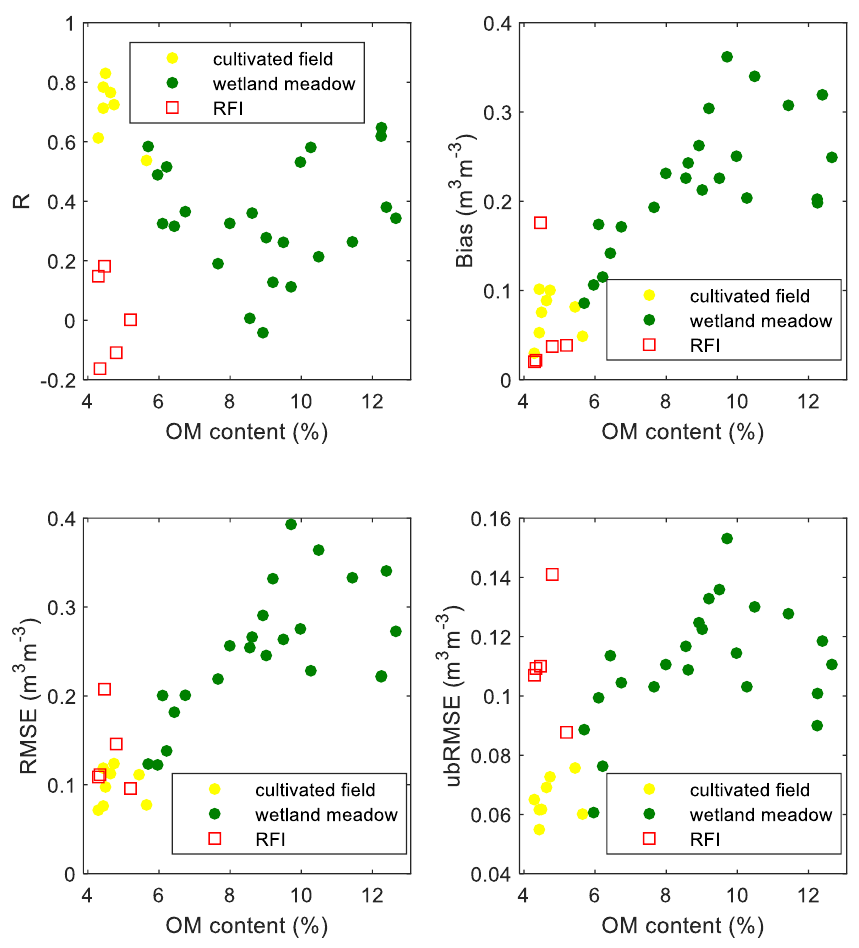
Figure 10. Statistics, by means of R bias, RMSE, and ubRMSE, of SM (L-MEB SRP modeling) vs. SM probe data in relation to OM content for three point-groups representing meadow wetland, cultivated field, and RFI regions.